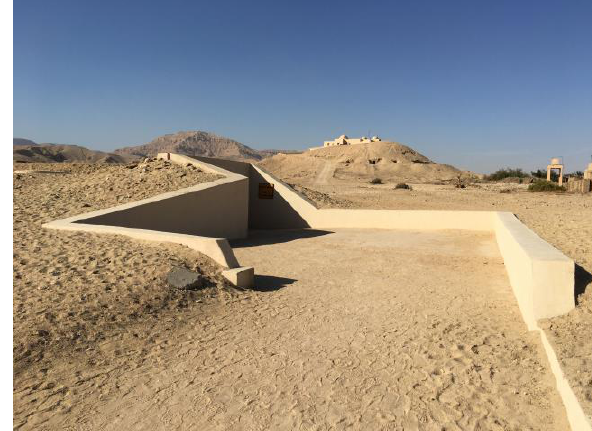
Figure 2. The entrance to the replica tomb of Tutankhamen at